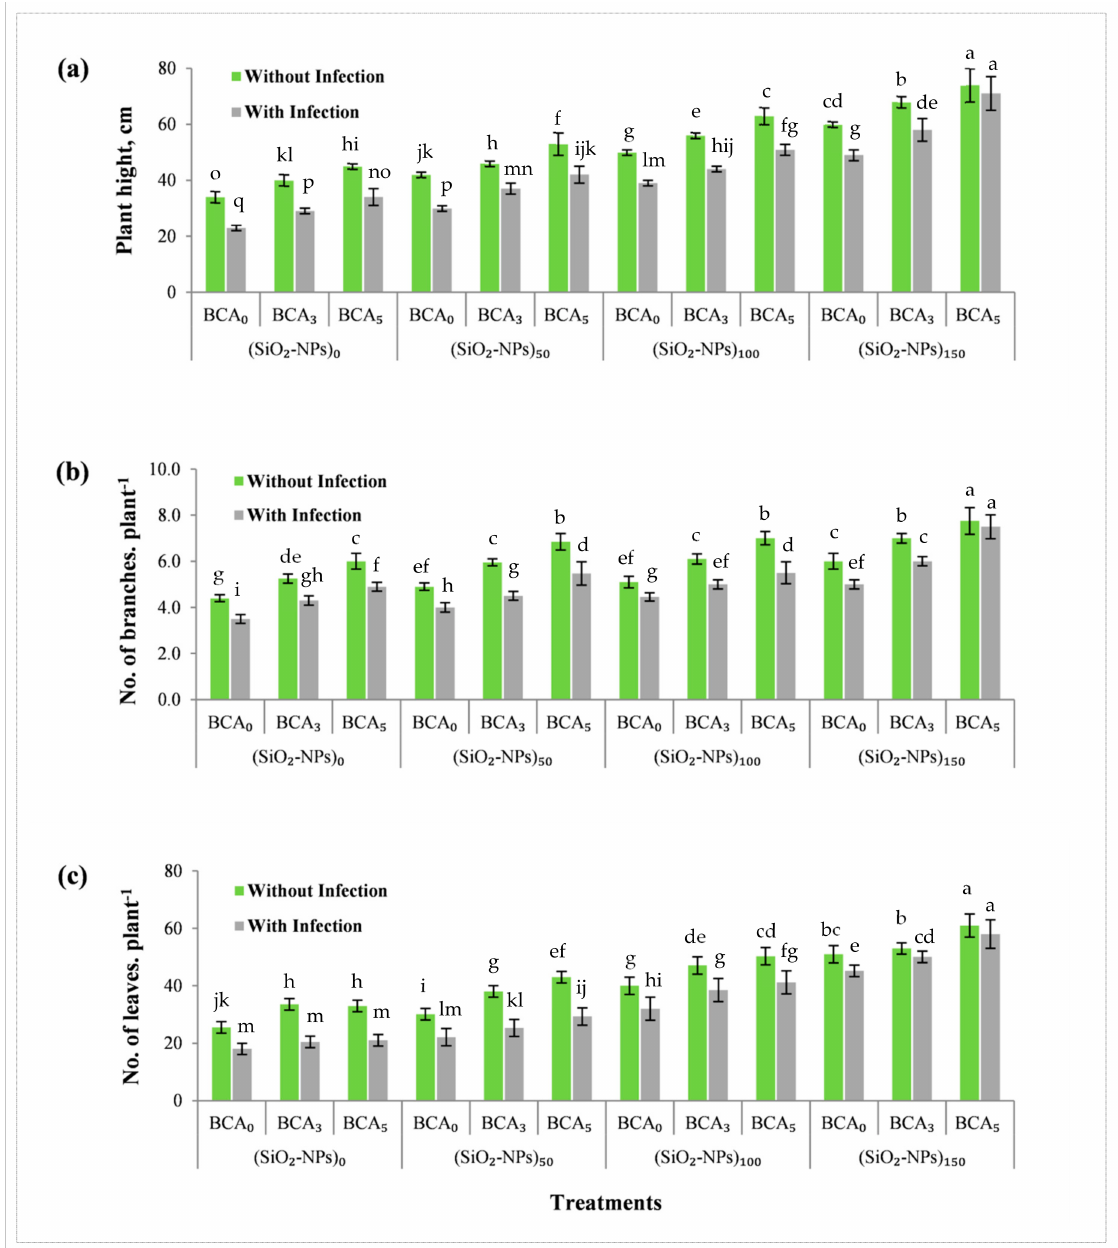
Figure 5. Vegetative growth parameters of sweet pepper at 90 days after transplanting, as affected by different treatments of SiO 2 -NPs (ppm), and BCA (%) without and with bacterial infection. ( a ) plant height, ( b ) number of branches per plant, and ( c ) number of leaves per plant. Error bars represent the mean ± standard deviation (SD) of the data of 5 replications. Different letter(s) above the error bars indicate statistically significant differences at ( p ≤